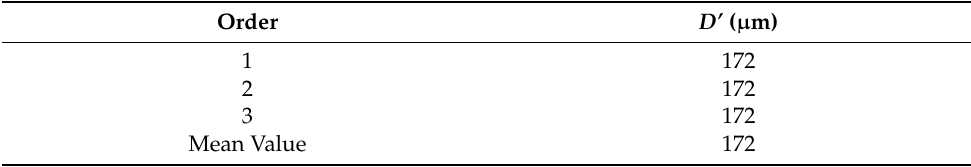
Table 3. The geometric thickness measured by the spiral micrometer.